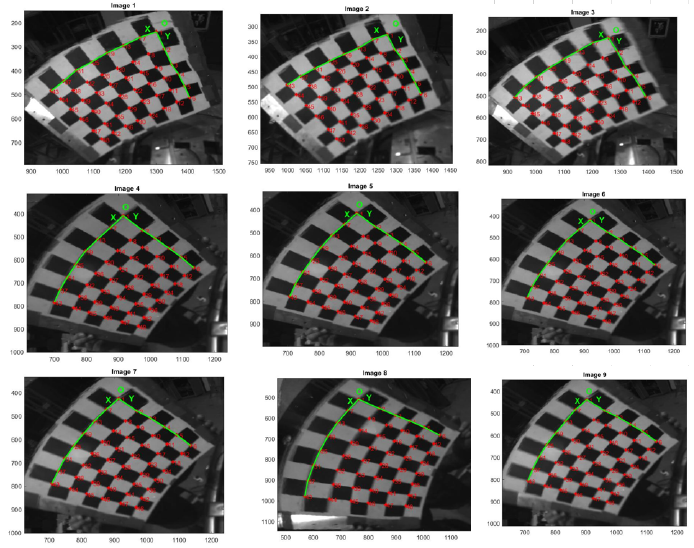
Figure 17. Extract grid corners.